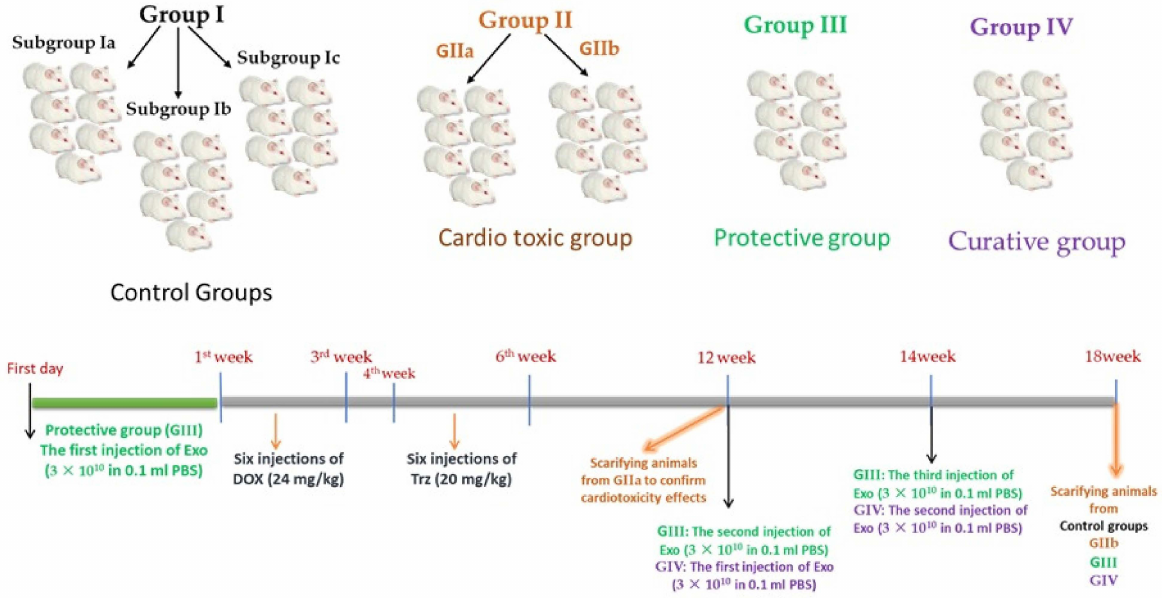
Figure 17. Timeline of the experimental